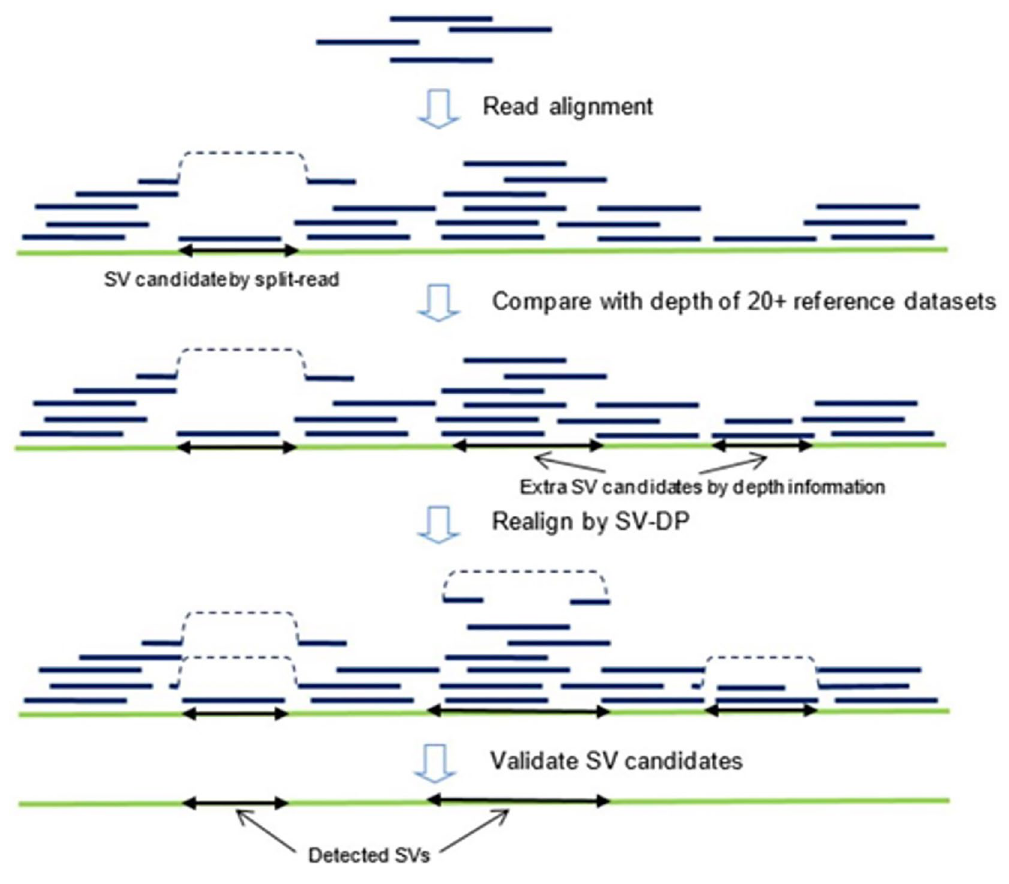
Figure 1. The workflow of